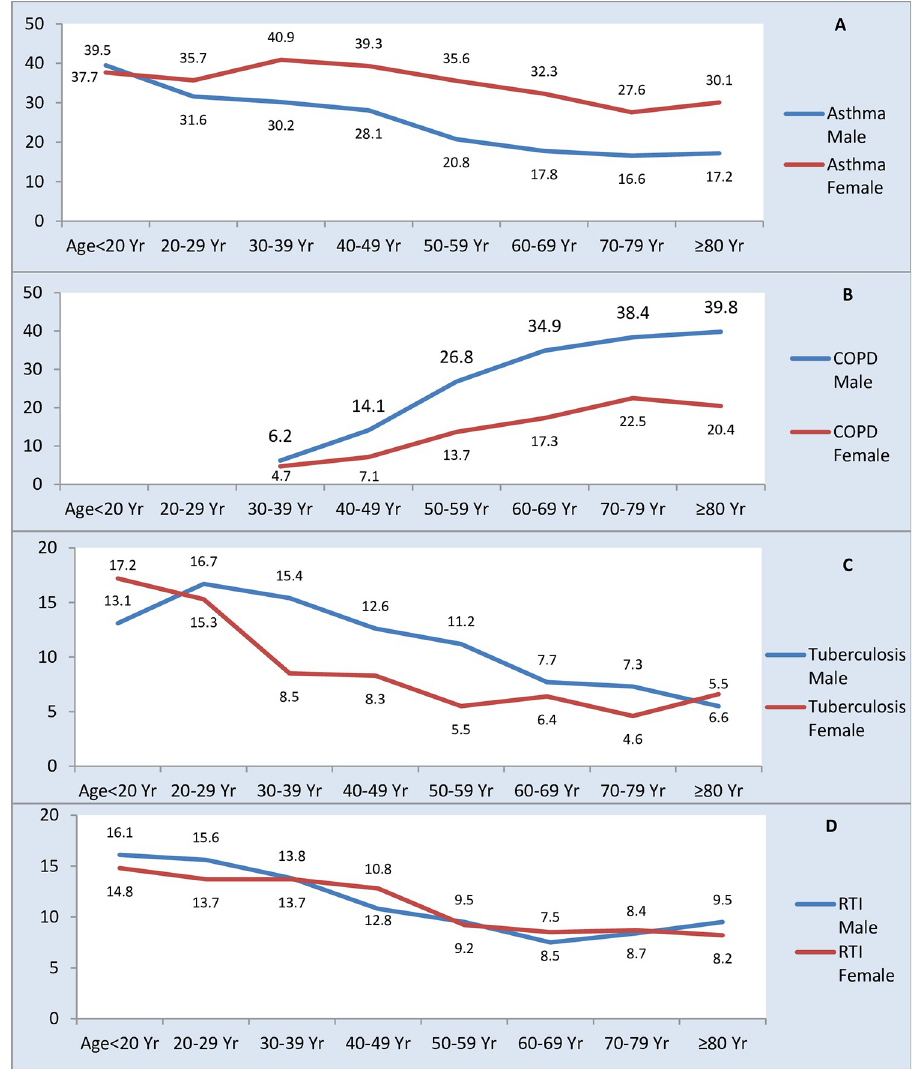
Fig 4. Age-wise proportion of respiratory diseases in males and females in the study population. Age-and sex wise distribution of prevalence of the major respiratory diseases. Differing distribution by age-and sex group were seen. Y- axis shows proportion of cases in a gender as per the age-groups